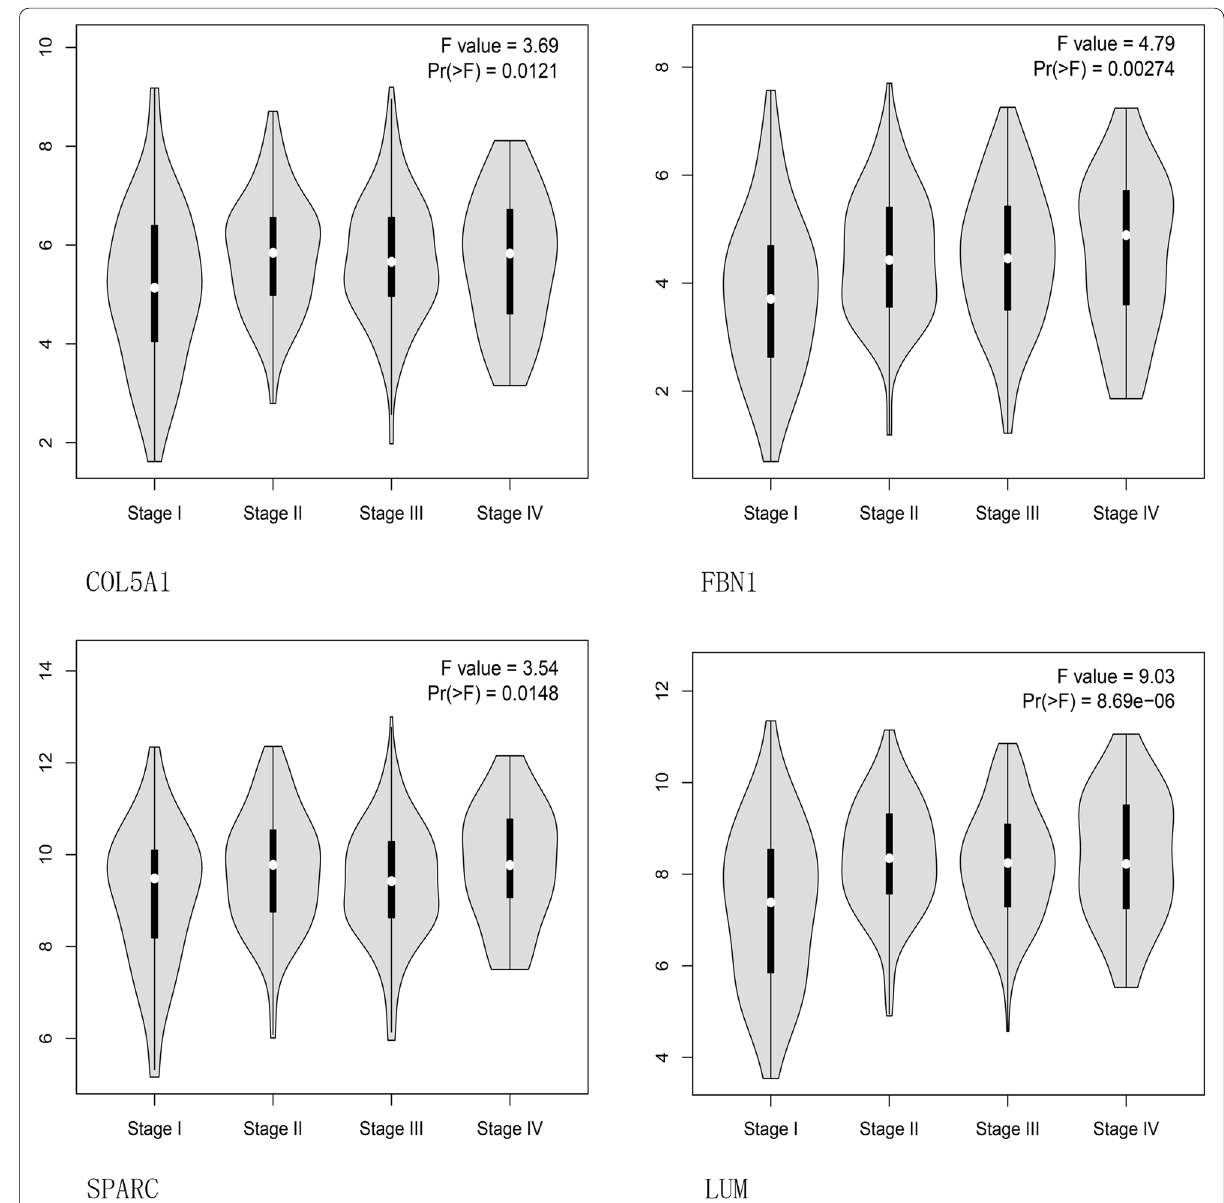
Fig. 4 Plots of four hub gene expressions in different stages of